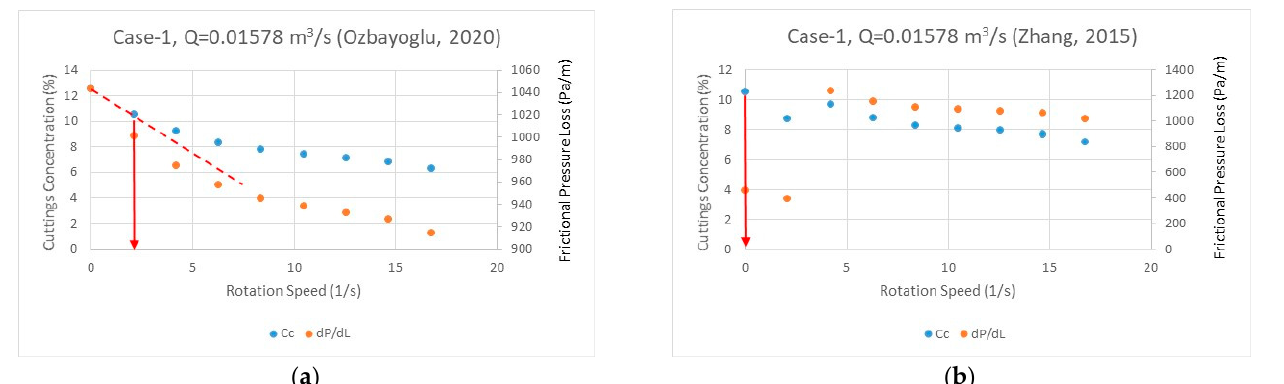
Figure 7. Determination of the optimal pipe rotation speed after the optimal flow rate is determined for Case 1: ( a ) Ozbayoglu’s model and ( b ) Zhang’s model.